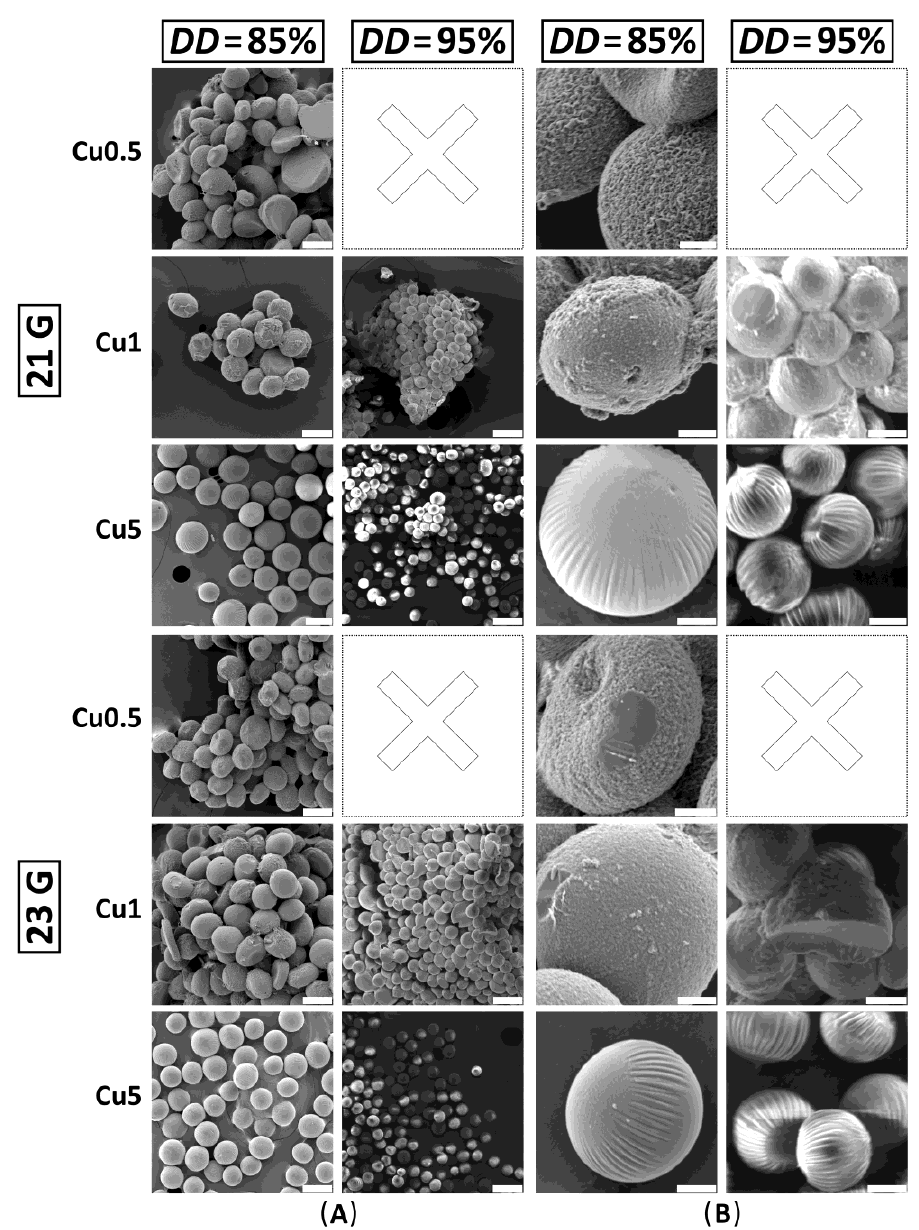
Figure 5. SEM micrographs of dried chitosan–Cu 2+ microspheres. CHT95–Cu0.5 microspheres were not obtained after dehydration and drying process. ( A ) The scale bar is 100 μm. ( B ) The scale bar is 20 μm.